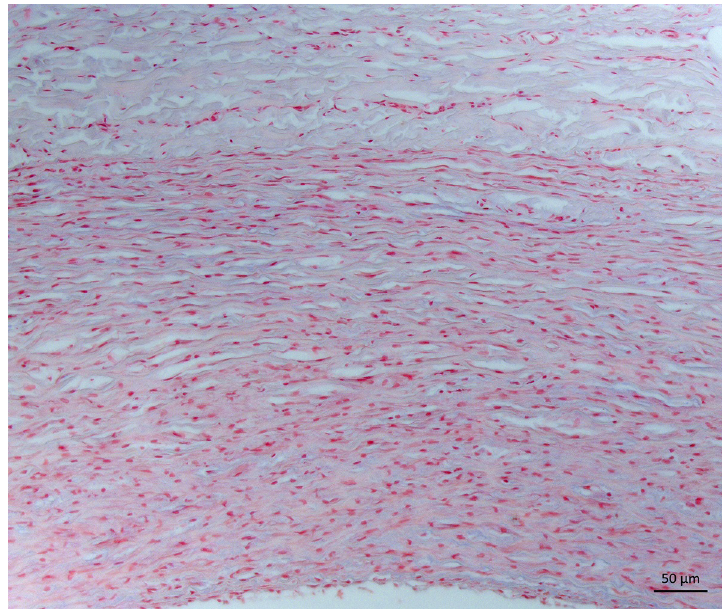
Figura 6. Artéria aorta com acentuado espessamento da túnica média pela grande quantidade de tecido fibroso, e aumento do espaçamento entre as fibras elásticas, Alcian blue ,